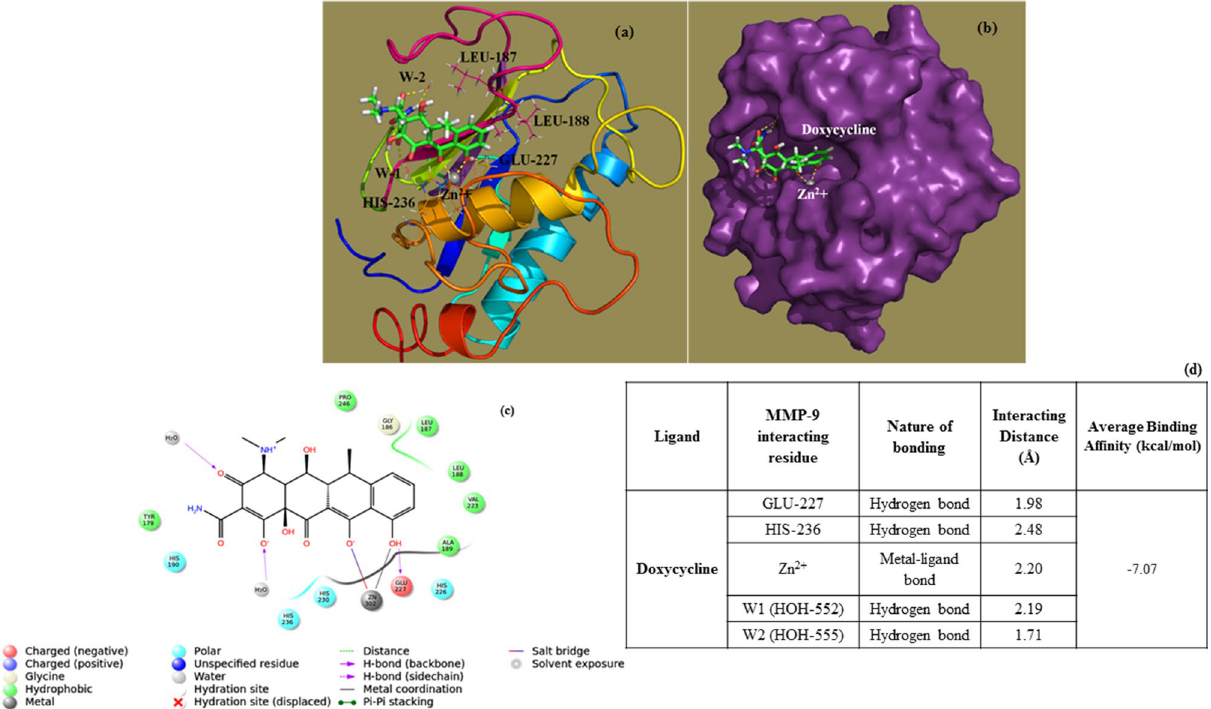
Figure 1. Molecular docking studies demonstrating doxycycline interaction with MMP-9 protein (PDB ID: 4XCT). Doxycycline interacting with active site residues of MMP-9 protein shown in sticks representation Table quantifying and describing molecular docking based atomic level interactions between MMP-9 active site residues and doxycycline ( d